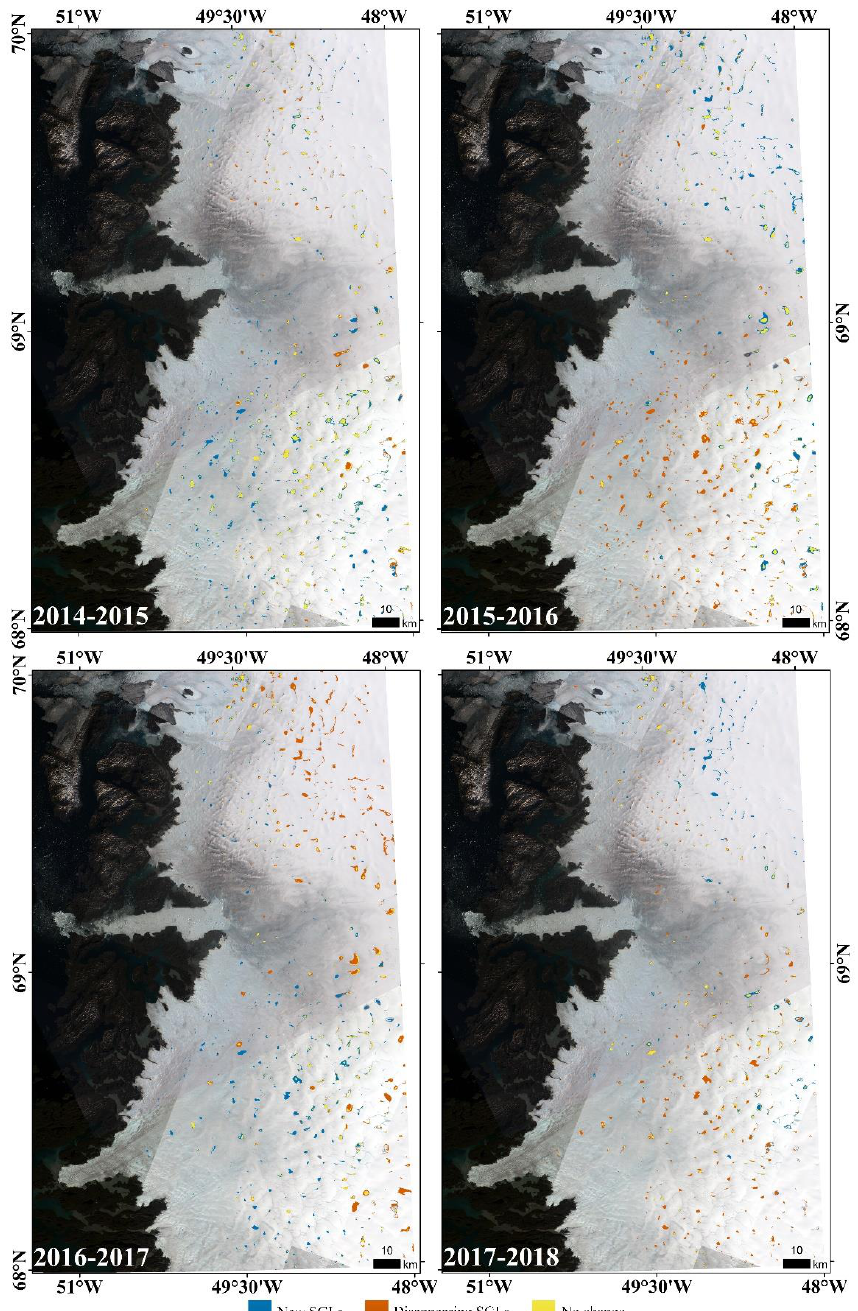
Figure 13. Spatial distribution of SGLs’ changes between two consecutive years from 2014 to 2018. We analyzed the elevation distribution and change of SGLs in the consecutive five years by a Digital Elevation Model (DEM). The DEM is from ASTER GDEMV2 with a resolution of 30 m. We calculated the mean elevation of all SGLs based on all pixels in the individual SGL, the elevation of the largest SGL, and the quantity proportions of SGLs in four elevation intervals. As shown with numbers in bold in Table 5, the mean elevation of SGLs and the proportion of SGLs above 1500 m are the highest in 2016, which proves that SGLs are more prevalent at higher elevations in 2016 compared to the other years. Combined with the finding in Figure 12 that the largest SGL appeared in 2016, our results are consistent with the discovery that lakes at higher elevations are also larger because their catchments are greater and the ice is thicker